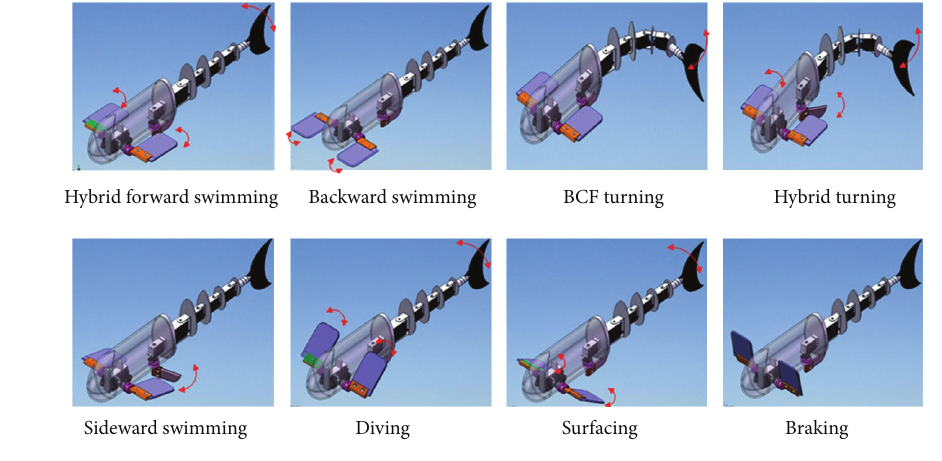
Figure 4: Schematic illustration of typical swimming gaits.